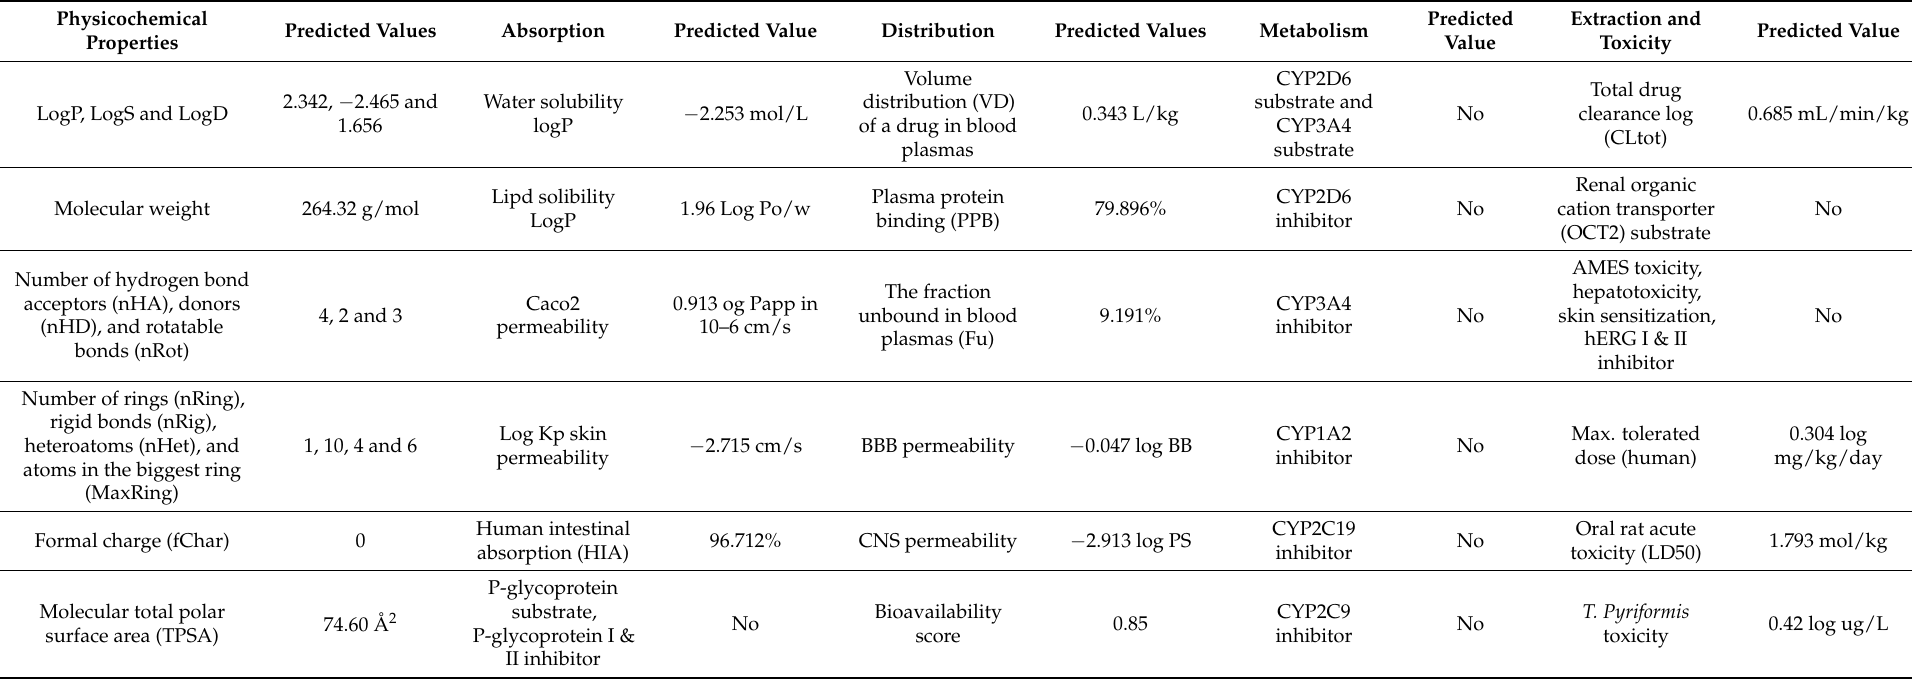
Table 3. In silico pharmacokinetics, physico-chemical, ADMET properties, and drug-likeness of